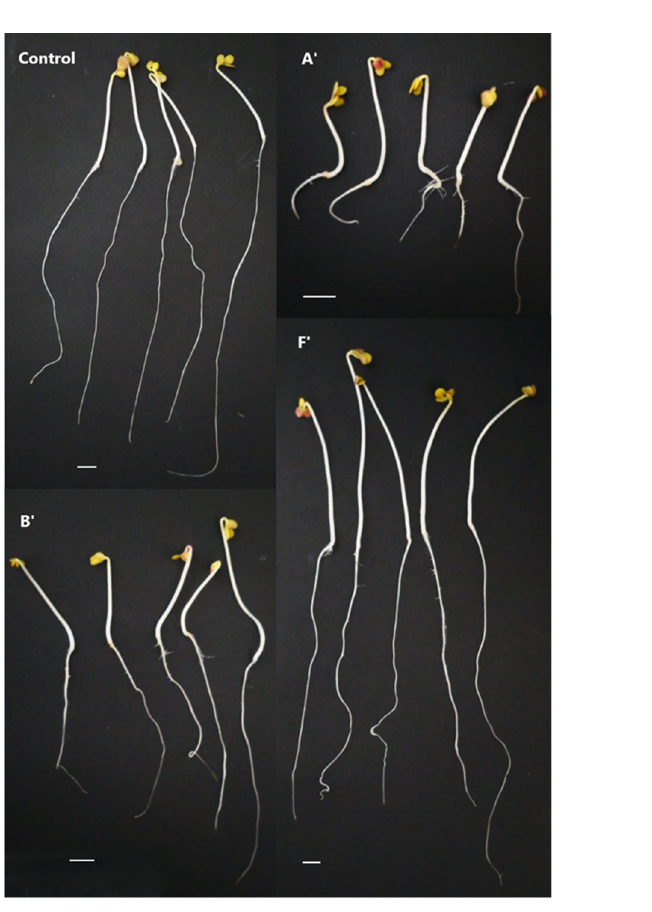
Figure 1. Mustard seedlings that grew for 5 days in water (control) and in potato leaf extracts of A’, B’, and F’ bulk samples. Bars: 1